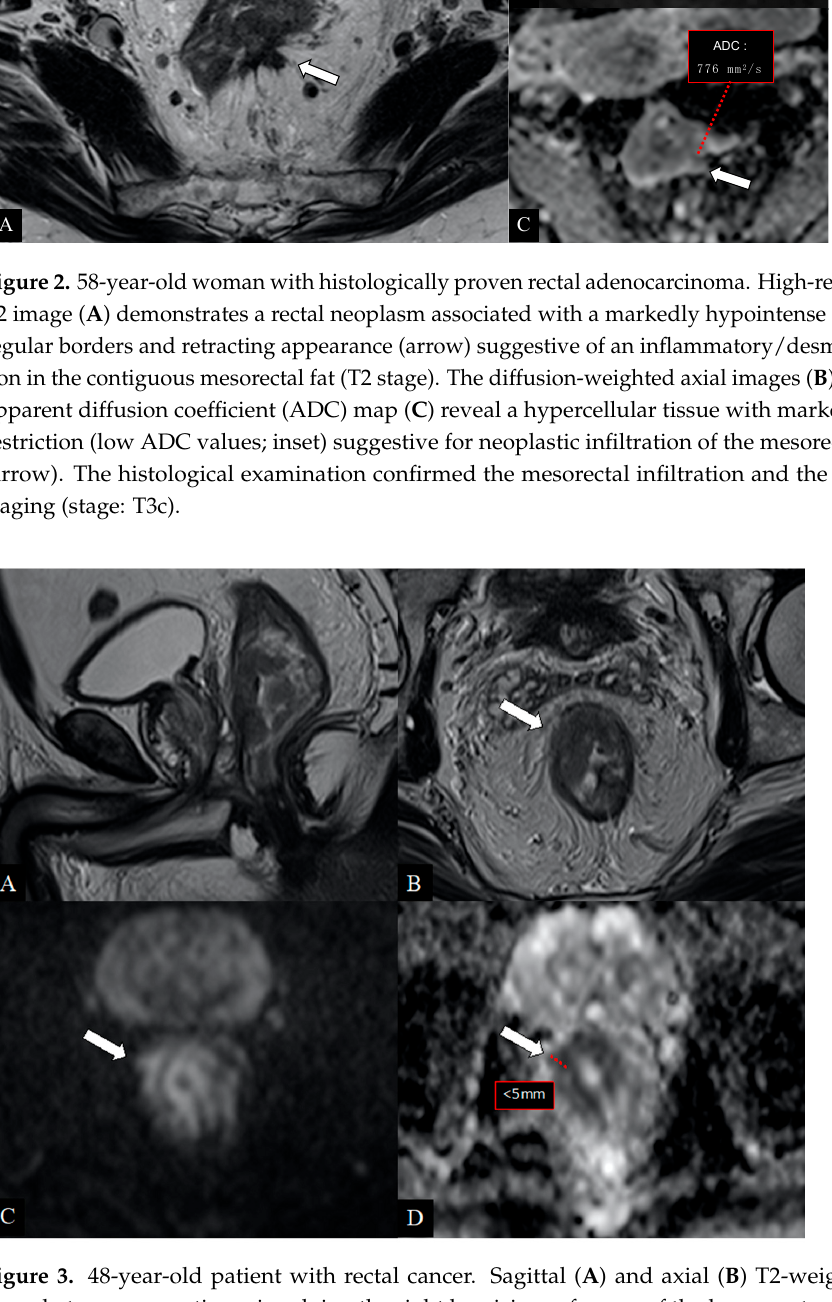
Figure 3. 48-year-old patient with rectal cancer. Sagittal ( A ) and axial ( B ) T2-weighted images show heterogeneous tissue involving the right hemicircumference of the lower rectum with a focal breakpoint at 10 o‘clock (arrow) doubtful due to wall infiltration (T2/T3 stage). The diffusion- weighted axial images ( C ) with relative ADC map ( D ) show a clear extraparietal component < 5 mm (arrows) with diffusion restriction and very low ADC map values (pathological hypercellular tissue). Histological examination confirmed the mesorectal extension of the disease (stage